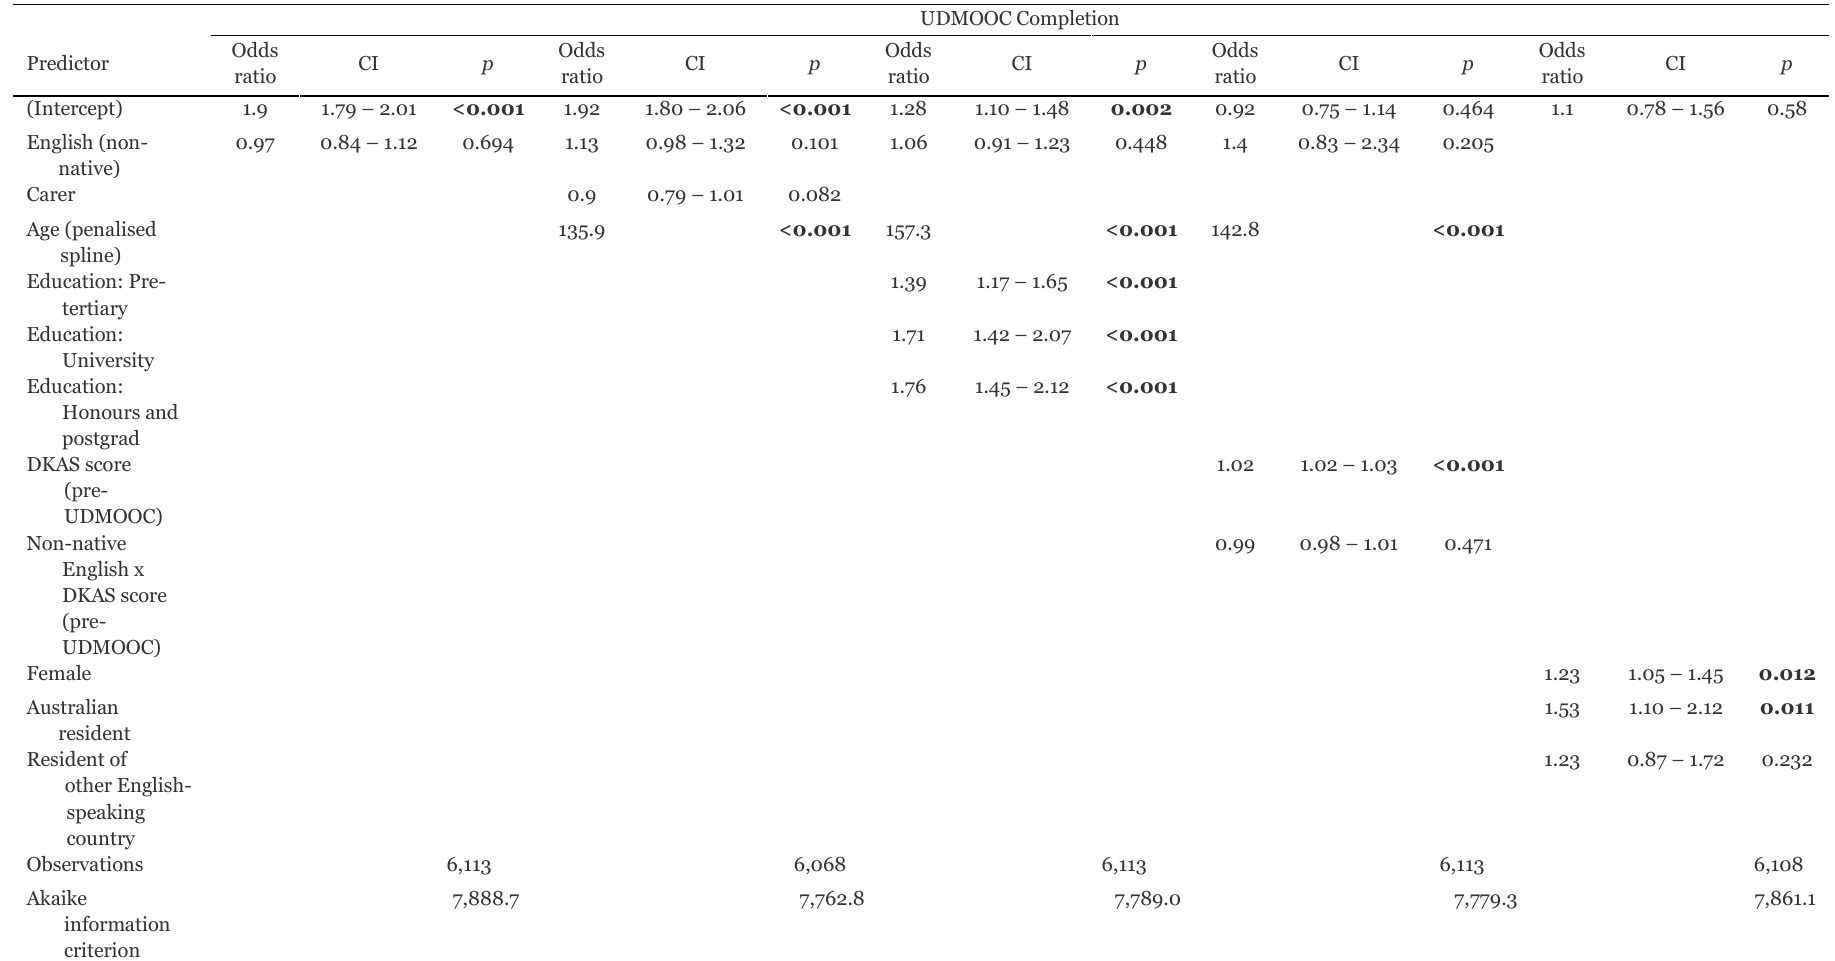
Odds Ratios with 95% Confidence Intervals for Expected UDMOOC